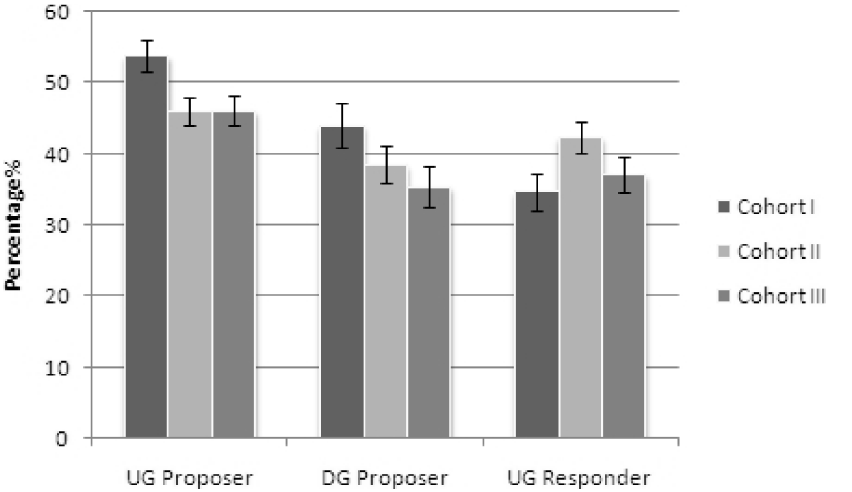
Figure 1. Mean offers (in %) for the ultimatum game (UG) and dictator game (DG) and minimal accepted offer for the ultimatum games. (The error bar is + / 2 1 standard error of mean.)